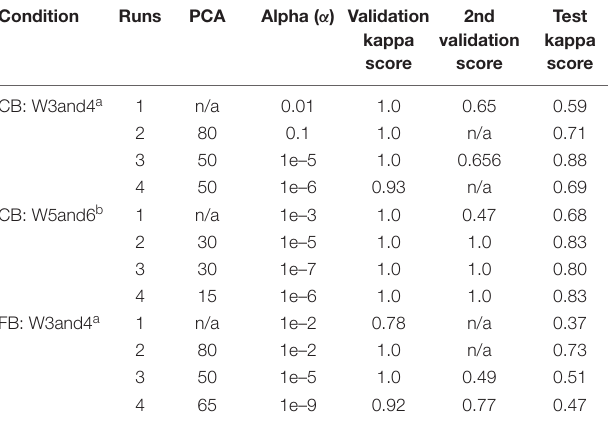
The number of feature reductions done per principal component analysis (PCA) and the kappa scores for the first and second validations, as well as the test validation, are also shown. a Weeks 3 and